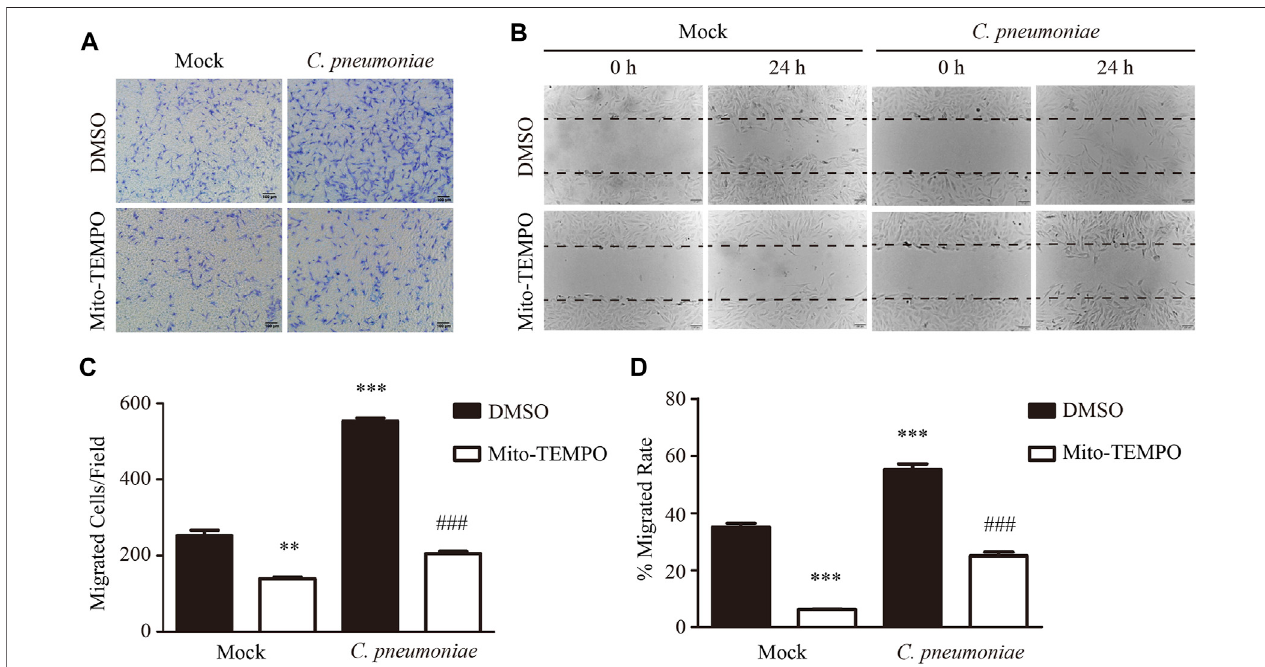
FIGURE 3 | C. pneumoniae infection induces VSMC migration through mtROS. (A − D) VSMCs were infected with C. pneumoniae (5 × 10 5 IFU). Mito-TEMPO (7 μ M,30 minpriorto C.pneumoniae infection)eliminated mtROSandinhibited C.pneumoniae infection-inducedVSMC migration. (A) RepresentativeimagesofVSMC migrationinTranswellassays.Scalebar:100 μ M. (B) RepresentativeimagesofVSMCmigrationinwoundhealingassays.Scalebar:100 μ M. (C) Thequantitativeresults formigratedVSMCs/ fi eld. ** p < 0.01, *** p < 0.001,compared withmockinfection andDMSOgroup, asanalyzed byStudent ’ s t -test. ### p < 0.001,compared with mock infection and Mito-TEMPO group, as analyzed by Student ’ s t -test. (D) The quantitative results for the area of wound closure were detected at 24 h after scratch. *** p < 0.001,comparedwithmockinfectionandDMSOgroup,asanalyzedbyStudent ’ s t -test. ### p < 0.001,comparedwithmockinfectionandMito-TEMPOgroup,as analyzed by Student ’ s t